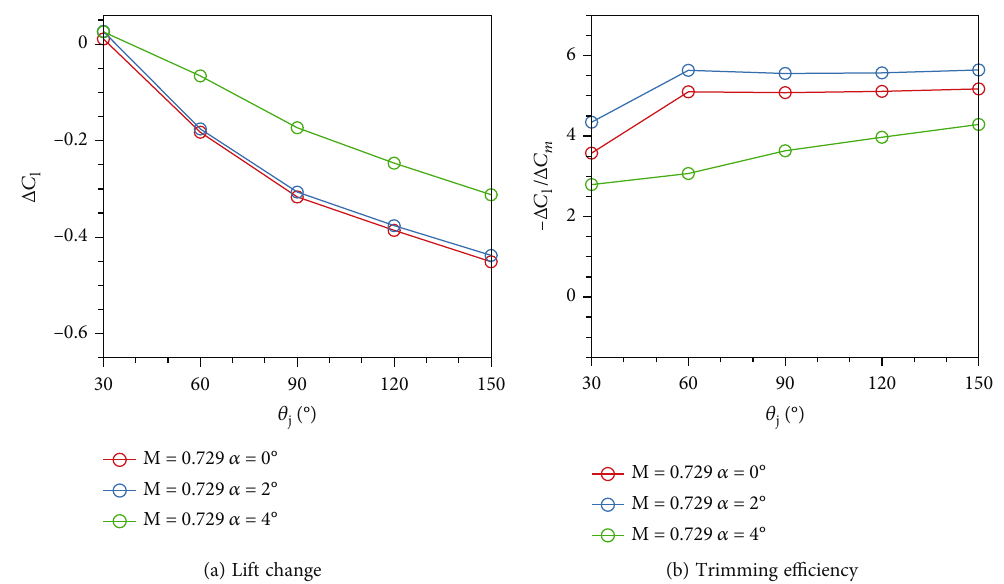
= 0 : 729 , α = 3 ° , and C ∞